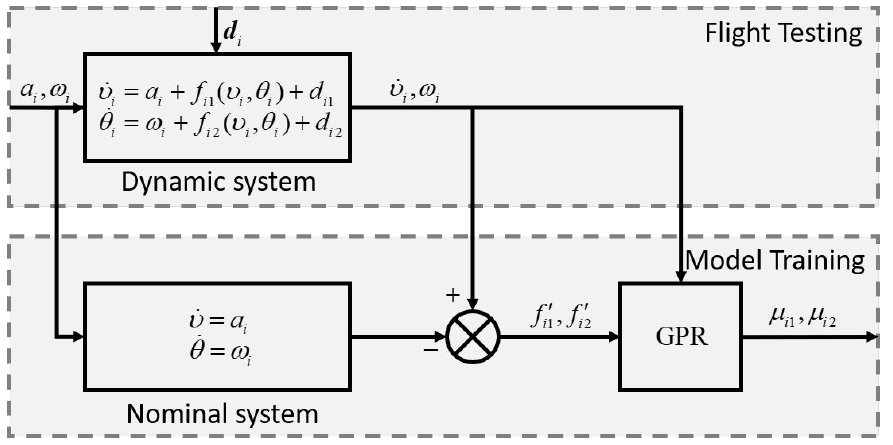
Figure 1. The framework of the process of modeling unknown dynamics